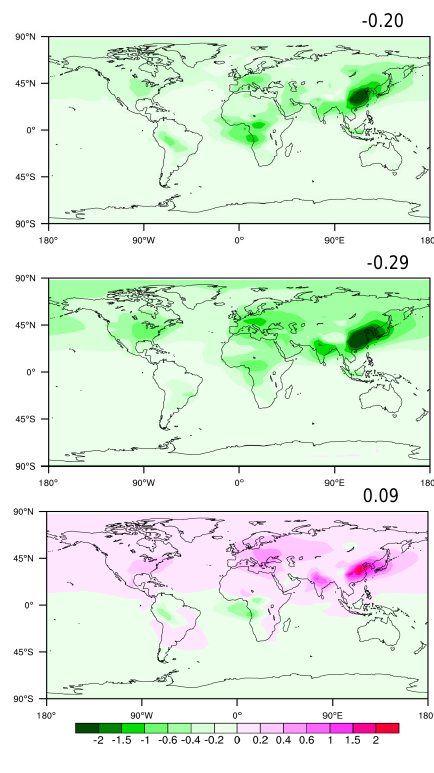
Fig. 13. Same as Fig. 11 but for the experiment